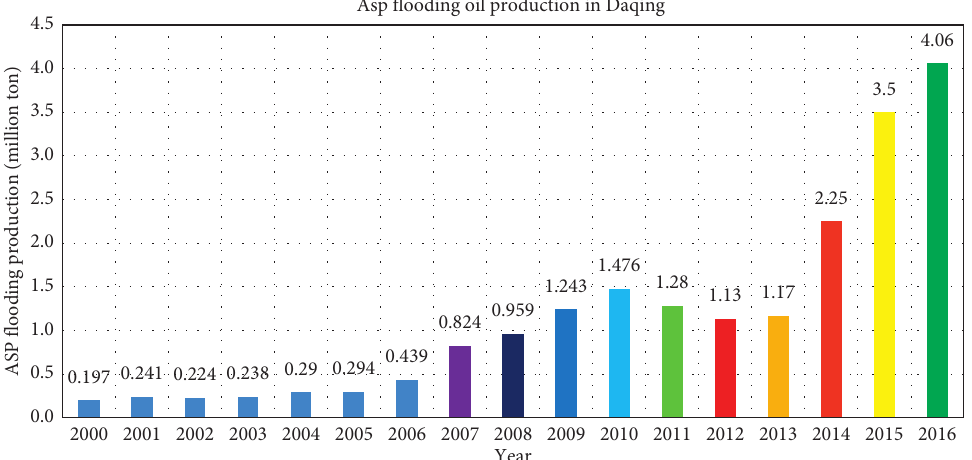
Figure 1: ASP flooding oil production in Daqing Oilfield [40].